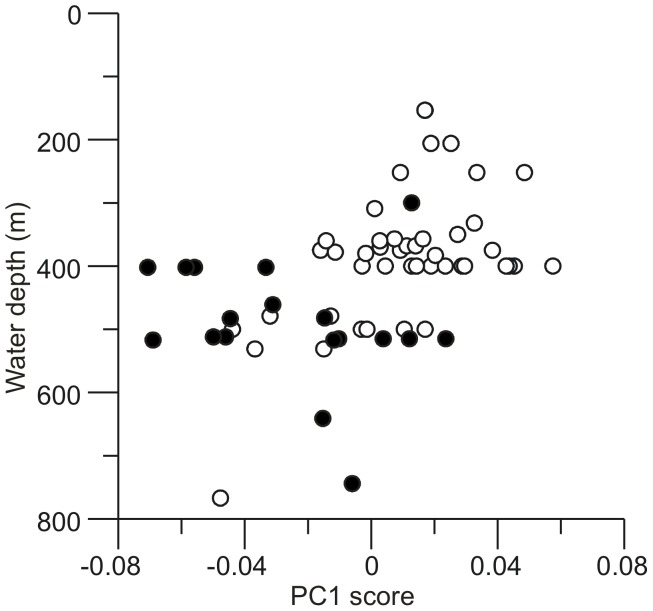
Comparison of morphometric shape with depth of collection of two benthic snail taxa, Alcithoe wilsonae and A. knoxi.
Scores of specimens on the morphometric first principal component axis plotted against water depth indicates a correlation between depth and morphology. The first principal component explains 66% of the total shape variation in the dataset. Open circles represent A. wilsonae specimens, filled circles represent A. knoxi specimens.